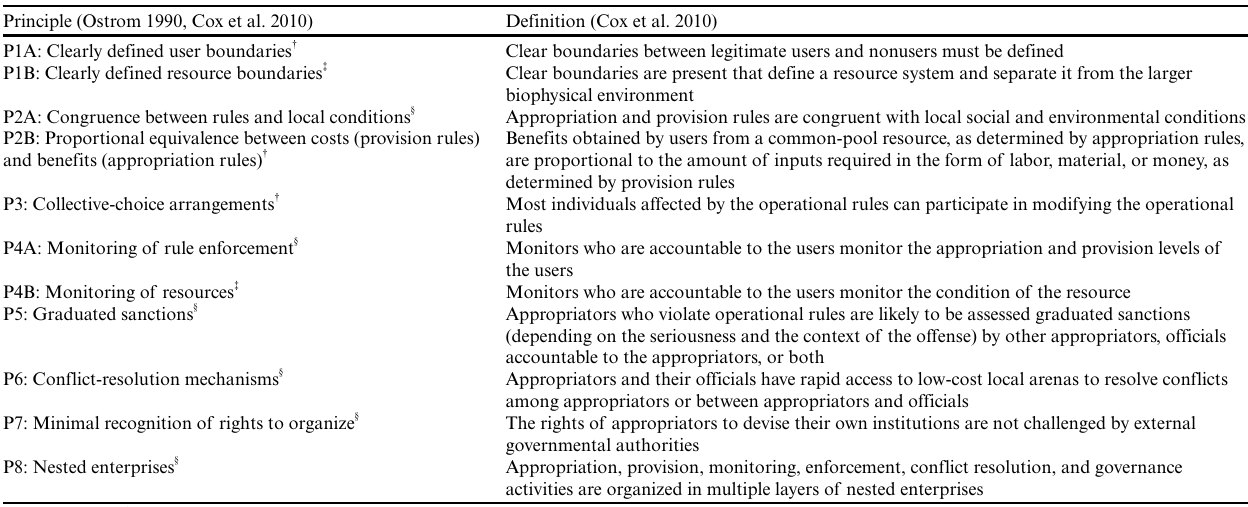
Table 1. List and definitions of Ostrom’s design principles (Ostrom 1990, Cox et al. 2010). Principles were categorized (symbols) according to Ostrom (2009).